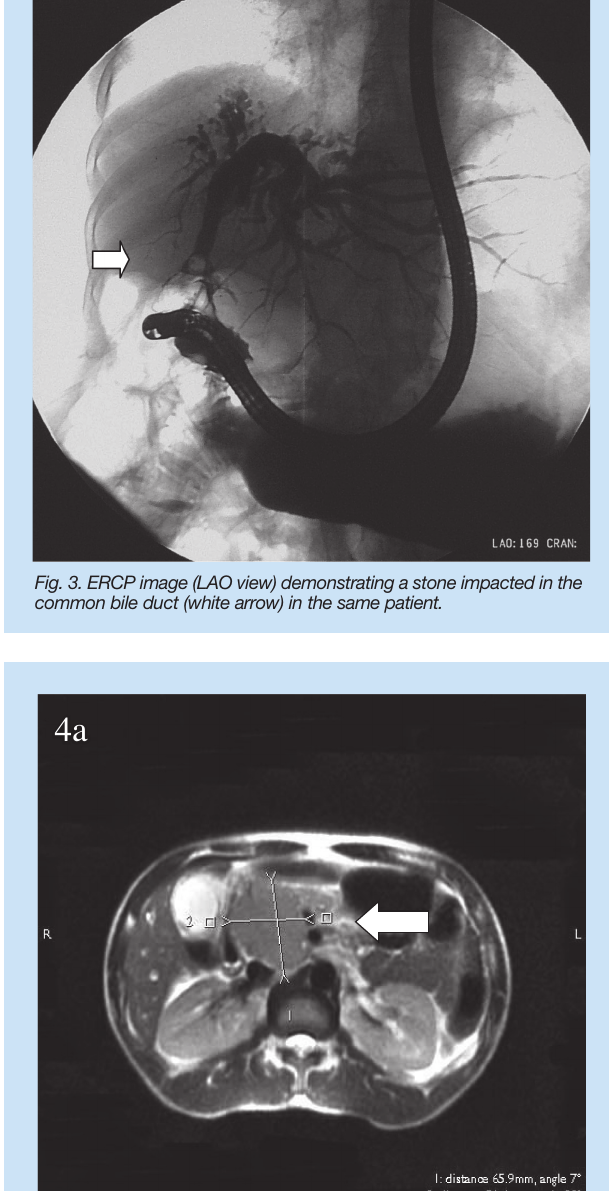
Figs 4a, b and c. MRIs demonstrating stenosis of the common bile duct (grey arrows) due to a tumour in the head of the pancreas (white arrow). Fig. 4a: Axial SSFSE T2; Fig. 4b: Coronal SSFSE T2; Fig. 4c: High-resolution thick slab long TE 1 100